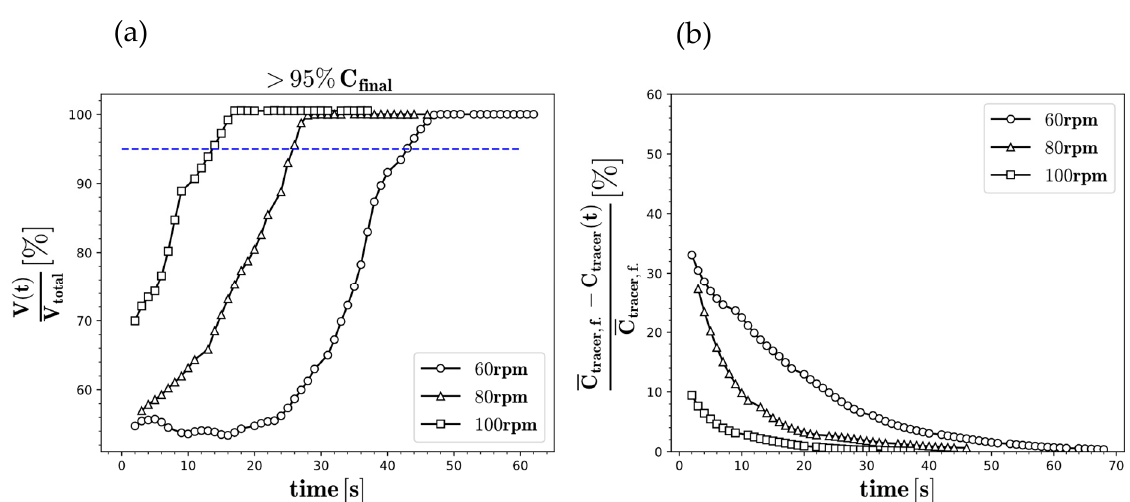
Figure 14. Percentage of total volume occupied with at least 95% of the final tracer concentration ( a ) and the average relative difference in mean tracer concentration within those volumes ( b ) for 60, 80, and 100 rpm. The blue dashed line locates a 95% volume occupation.